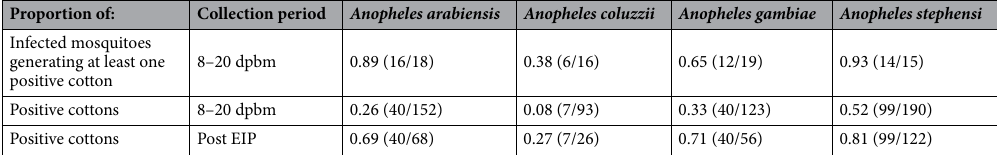
Table 1. Proportion of mosquitoes producing at least one positive cotton over the collection period and proportion of positive cottons both over the collection period and after the first positive detection (“post-EIP”) for each anopheline species.